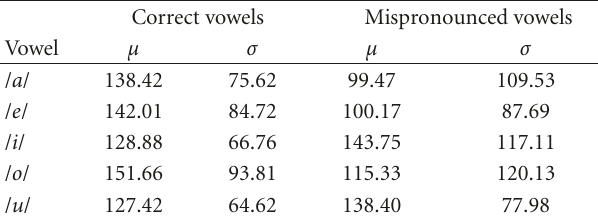
Table 12: Mean ( μ ) and standard desviation ( σ ) of length in the impaired